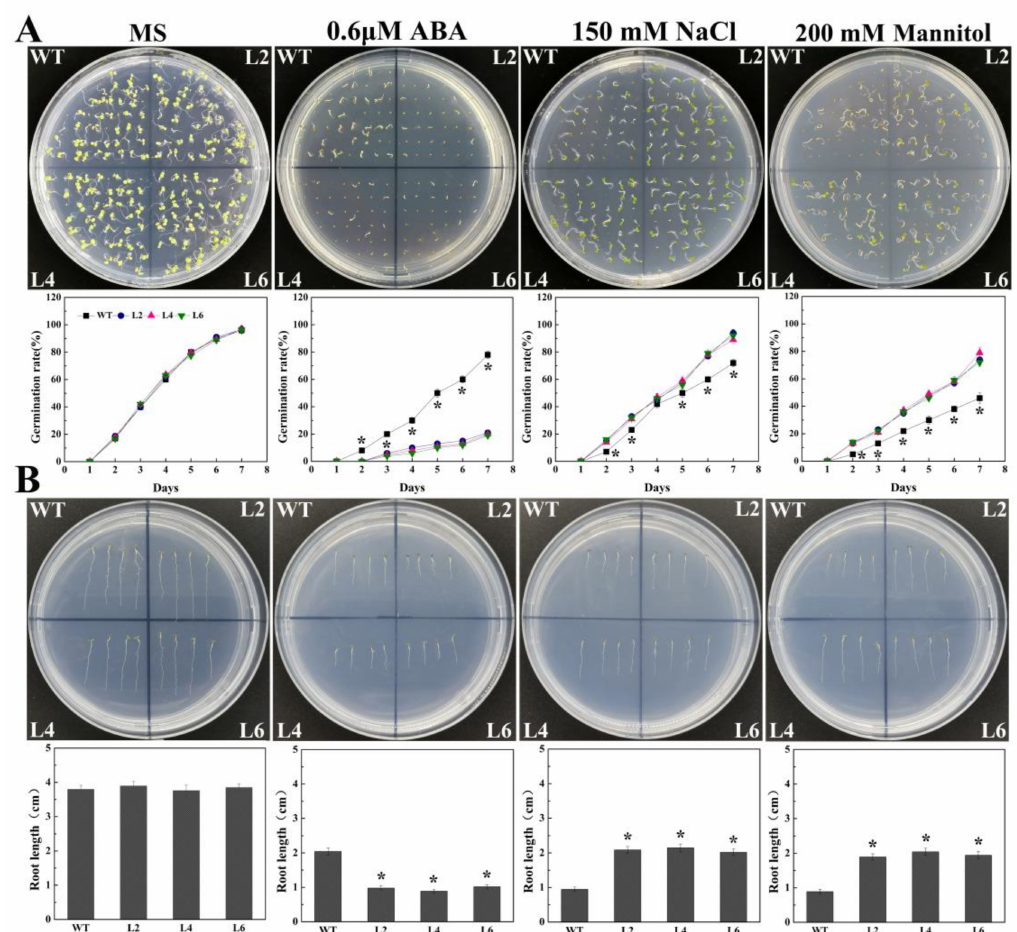
Figure 4. Comparison of the e ff ects of abiotic stress on seed germination and root elongation of WT plants and of the transgenic lines. ( A ) The germination rate of the WT plants and transgenic line seeds cultured on 0.6 µ m ABA, 150 mM NaCl and 200 mM mannitol in 1 / 2-strength MS medium for 7 days. ( B ) The phenotype and root length of transgenic and WT plants were analyzed on 1 / 2-strength MS plates with 0.6 µ m ABA, 150 mM NaCl and 200 mM mannitol for 10 days. The growth of the WT plants and transgenic lines in the 1 / 2-strength MS plates was used for control values. The means ± SD represent each value from three replicate experiments. * Indicates a significant di ff erence between the transgenic lines and the WT plants ( p <